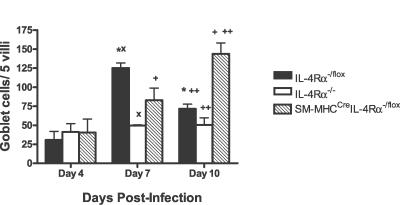
Intestinal Goblet Cell Hyperplasia Is Delayed in SM-MHCCreIL-4Rα−/lox Mice following Infection with N. brasiliensis
Mucus-producing goblet cells were visualized using periodic−acid Schiff reagent staining at days 4, 7, and 10 PI. The number of hyperplasic goblet cells per five villi was calculated. Values indicate mean ± SD, with *, x, +, and ++ indicating significant differences between groups (p < 0.05). *Significant decrease in hyperplasic goblet cells in IL-4Rα−/lox mice at day 10 PI compared to IL-4Rα−/lox mice at day 7 PI. x, Significantly less hyperplasic goblet cells in IL-4Rα−/− mice than in IL-4Rα−/lox mice at day 7 PI. +, SM-MHCCreIL-4Rα−/lox mice had significantly more hyperplasic goblet cells at day 10 PI than did SM-MHCCreIL-4Rα−/lox mice at day 7 PI. ++, SM-MHCCreIL-4Rα−/lox mice had significantly more hyperplasic goblet cells than did IL-4Rα−/lox mice at day 10 PI. Data are representative of four separate experiments.